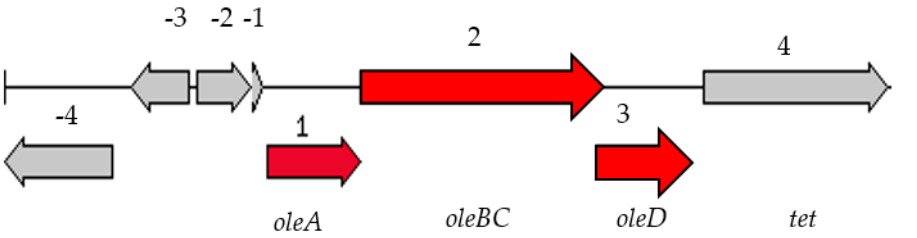
Figure 4. Genome localization and surrounding genes of the alkane synthesis cluster of Plantacti- nospora alkalitolerans S1510 T . -4: NADH dehydrogenase (EC 1.6.99.3); -3: Thioredoxin reductase (EC 1.8.1.9); -2: Transcriptional regulator SCO1200, Xre-family with cupin domain; -1: Hypothetical protein; 1: 3-oxoacyl-[ACP] synthase III; 2: Haloalkane dehalogenase-like protein—AMP-dependent synthetase/ligase; 3: NAD(P)H steroid dehydrogenase-like protein; 4: Ribosome protection-type tetracycline resistance. All genes are in contig NODE_88 of the deposited genome sequence. Table 3. Genes related to the metabolism of aromatic compounds identified in the genome of the Plantactinospora strain S1510 T . Description No. of Genes